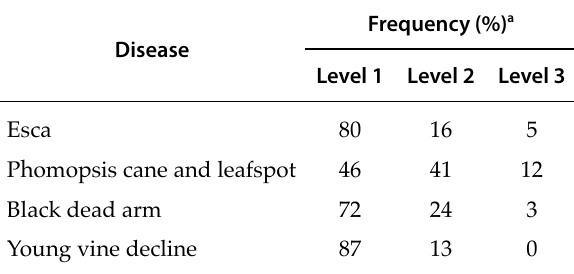
Table 3. Frequency of grapevine trunk diseases in Dão wine region: level 1 - affects few vines; level 2 - affects some vines; level 3 - affects many